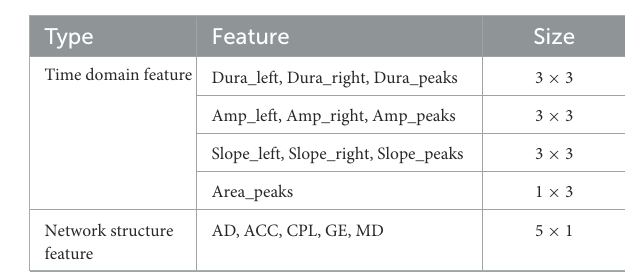
TABLE 1 Size of candidate spike morphological characteristics and FBN-PLV